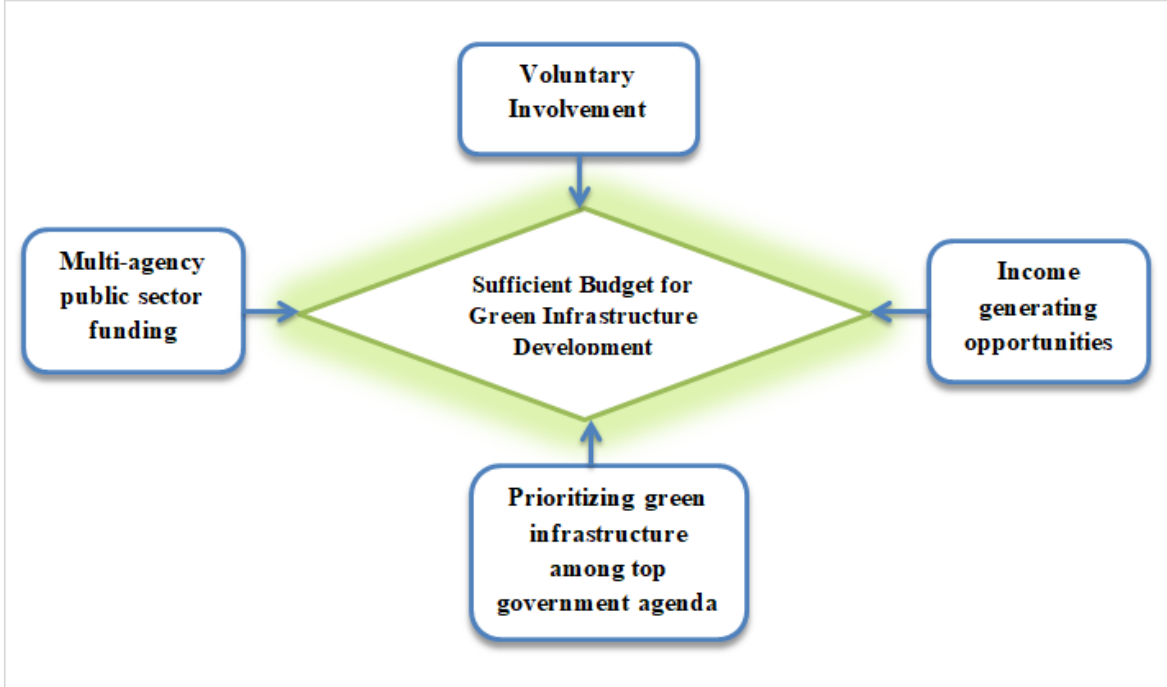
Figure 4. Different funding approaches to improve the development and management of green infrastructure compo- nents.